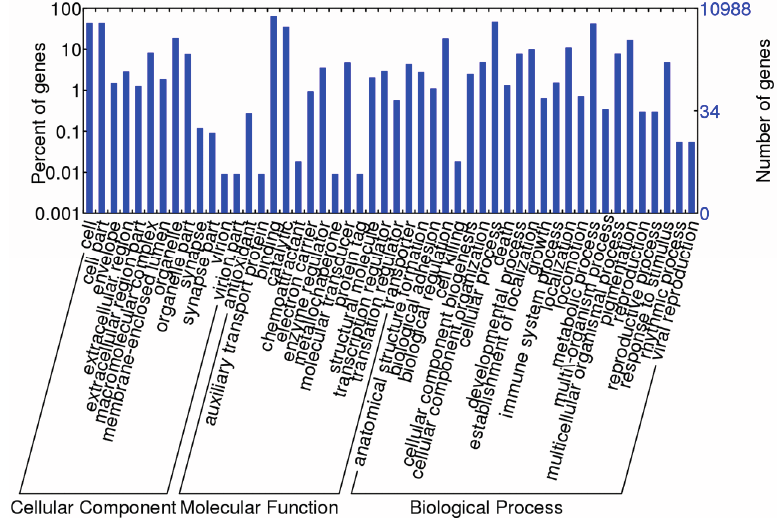
Figure 2. Gene ontology (level 2) for assembled transcriptome contigs under molecular functions, cellular components, and biological processes.